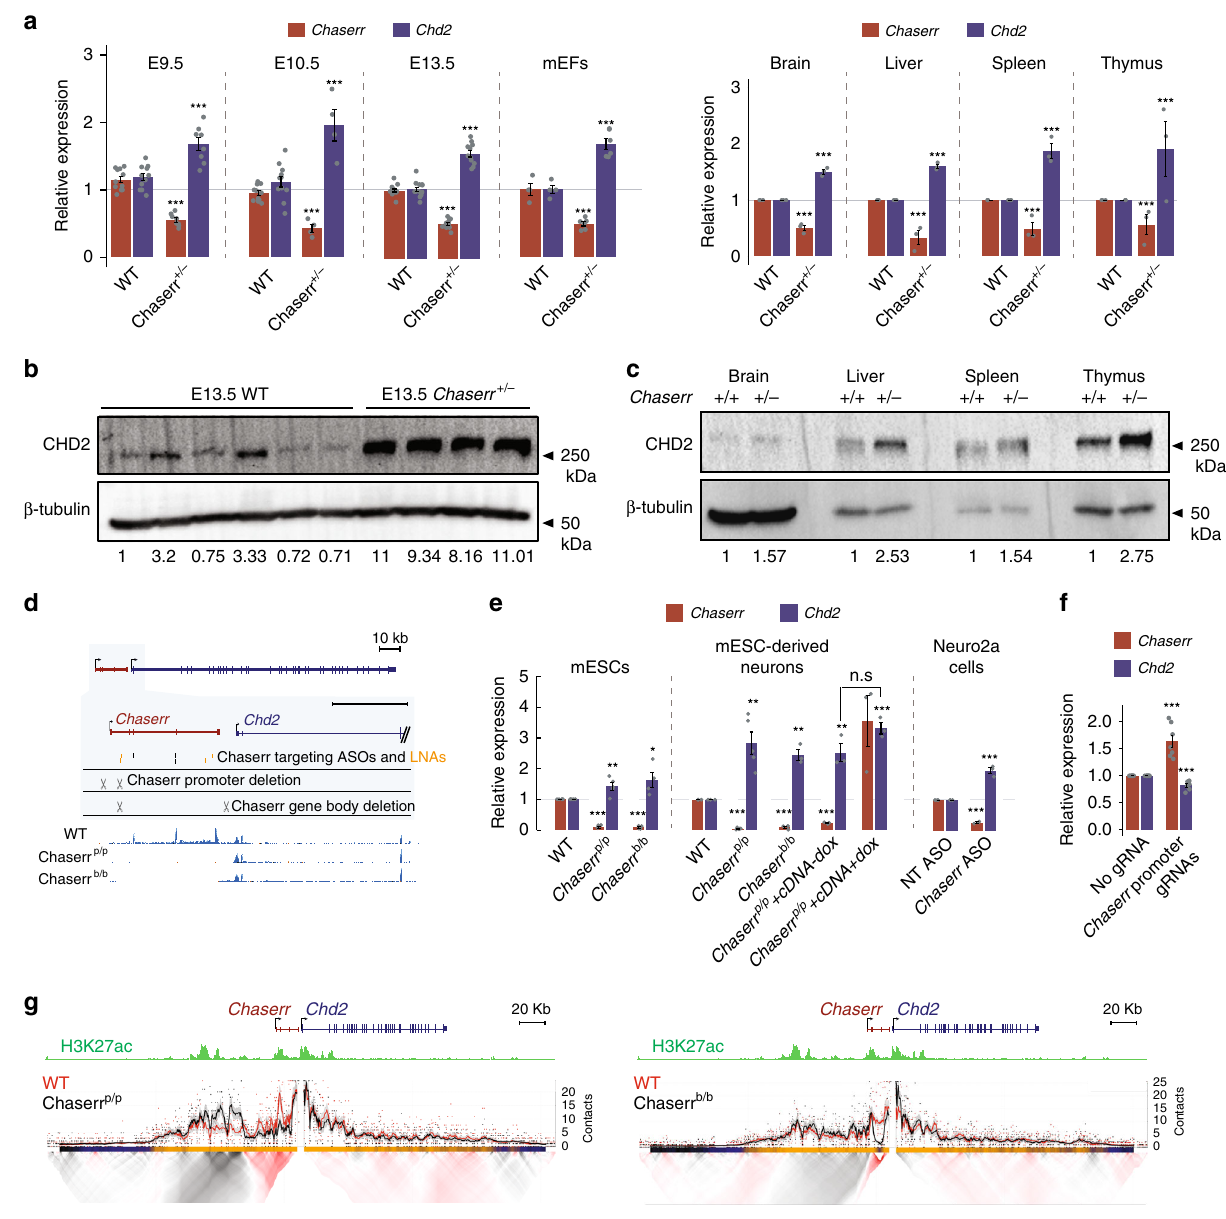
Fig. 2 Chaserr represses Chd2 expression. a qPCR of the indicated genes in whole embryos from the indicated developmental stage, mEFs, or adult tissues with the indicated background. n for each group of embryos or mEFs is indicated in parentheses. Normalized to Actb . n = 3 for the tissues. b Western blot for the indicated protein in individual E13.5 whole embryos from indicated background. c As in b for the adult tissues. d Top: scheme of regions targeted by gRNAs used to generate Chaserr p/p , Chaserr b/b mESCs, or the antisense reagents; Bottom: RNA-seq read coverage in mESCs from the indicated background. e , f qRT-PCR of the indicated genes in the indicated backgrounds or treatments. Normalized to Actb . n = 3 – 5. g Targeted Chromosome Conformation Capture (4C) analysis with the Chd2 promoter as the viewpoint in WT vs. Chaserr p/p (left) or WT vs. Chaserr b/b (right) mESCs. Top to bottom: scheme of the Chd2 - Chaserr locus; H3K27ac ChIP-seq signal in mESCs; smoothed trend lines and raw counts of the contact pro fi les in the indicated cell lines; domainogram 79 showing mean contact per fragment end for a series of window sizes. Ratio quanti fi cations are shown below Western